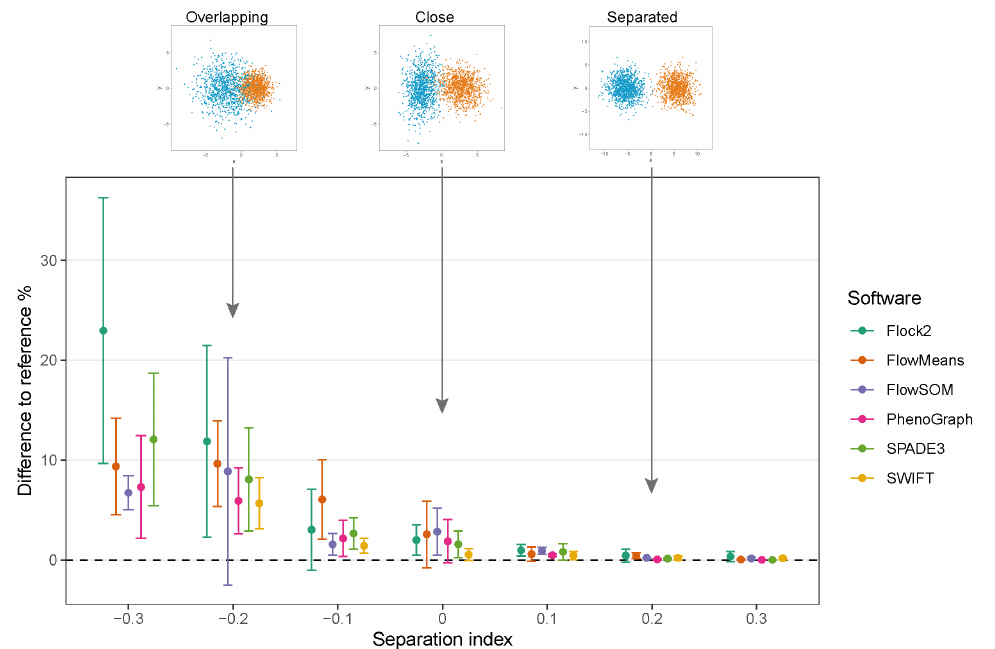
Figure 4. Performance of different software with a two-cluster separation